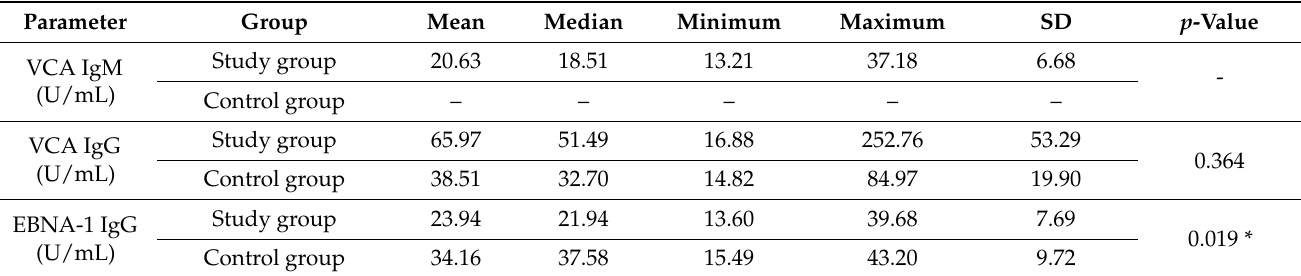
Table 4. Evaluation of anti-VCA antibodies in the IgM and IgG class and anti-EBNA-1 in the IgG class in the study group and the control group.